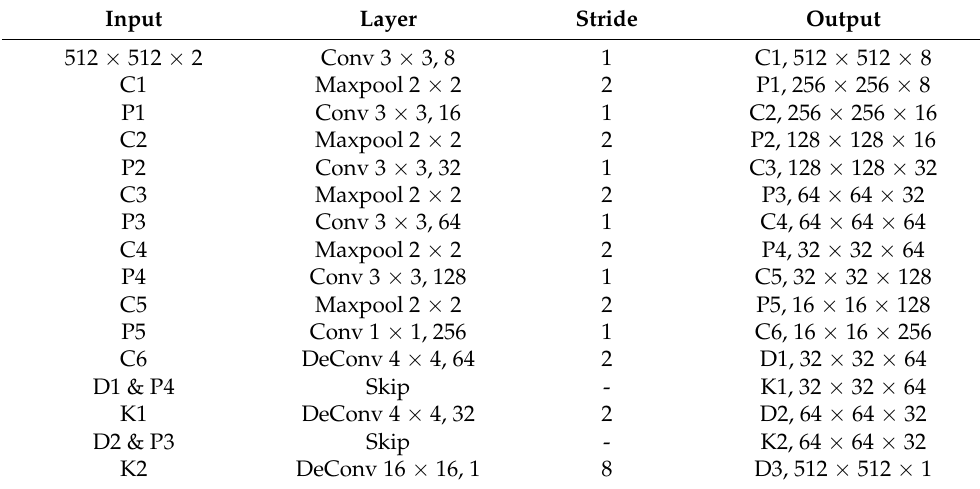
Table 2. Structure of DHM-FCN